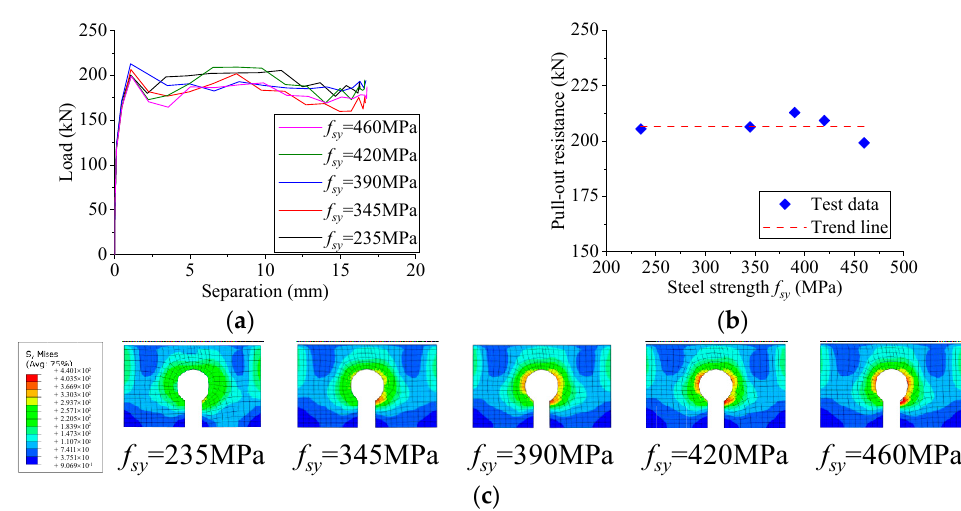
Figure 20. Influence of steel strength. ( a ) Load–separation curves; ( b ) influence analysis; ( c ) failure mode.